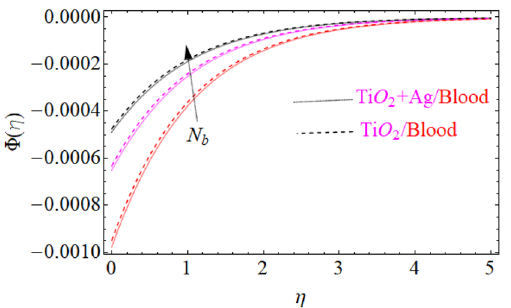
Figure 16. Under the influence of N b (Brownian motion parameter), �(η)